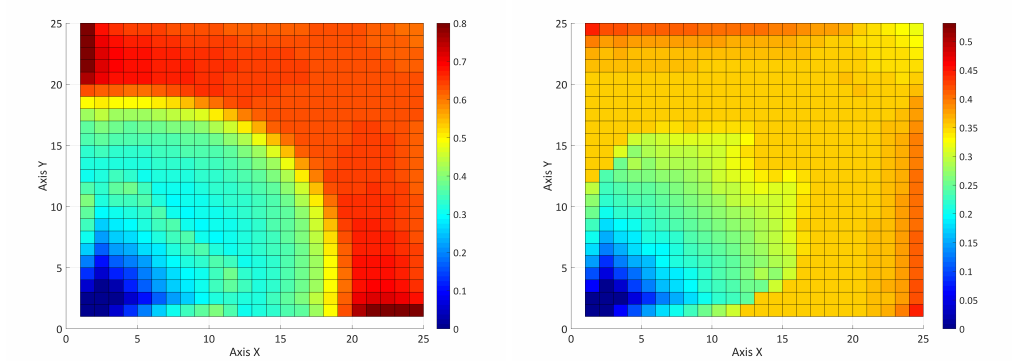
Figure 12. Oil saturation in a P+S overlapped scheme after 500 days ( left ) and 3000 days ( right ) in a porous medium considering adsorption and the presence of salt in the aqueous phase.